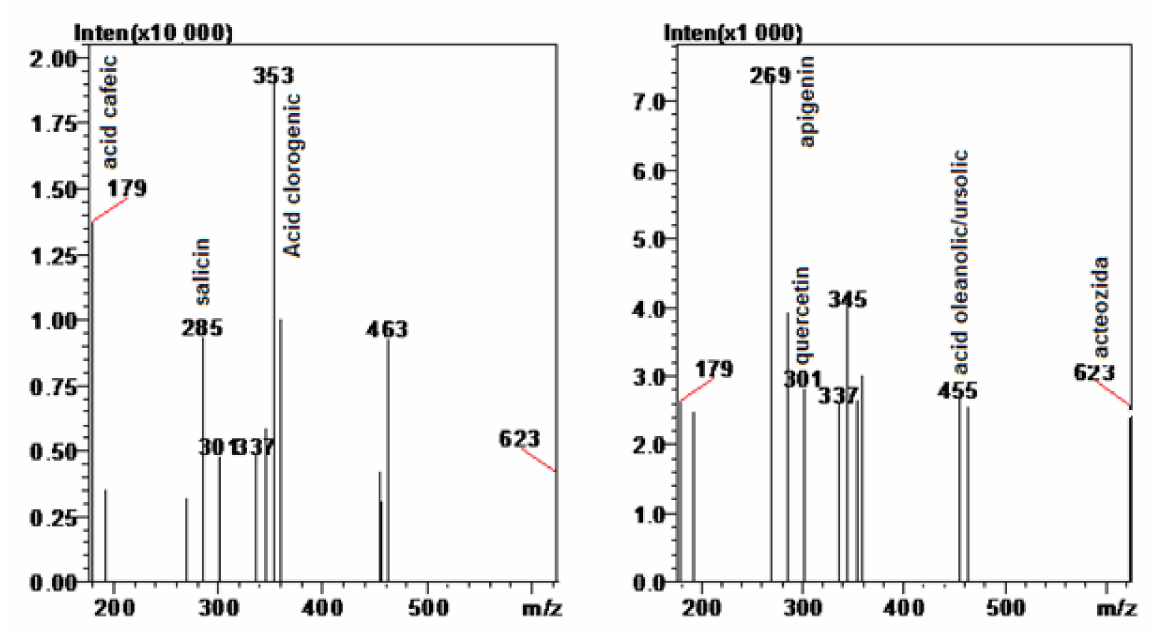
Figure 3. Mass spectra of the formula, normalized for apigenin and chlorogenic acid. Rosemary and poplar buds are well known sources of phenolic compounds but the amount and relative contribution of each class of (poly)phenolic compounds from rosemary extracts were reported to be dependent on the extraction procedure and solvent